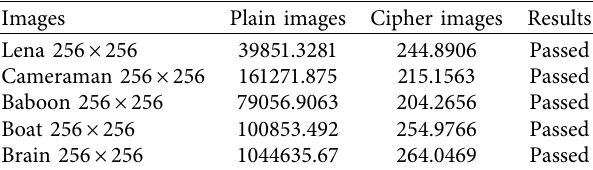
Table 6: Entropies of original images and cipher images.